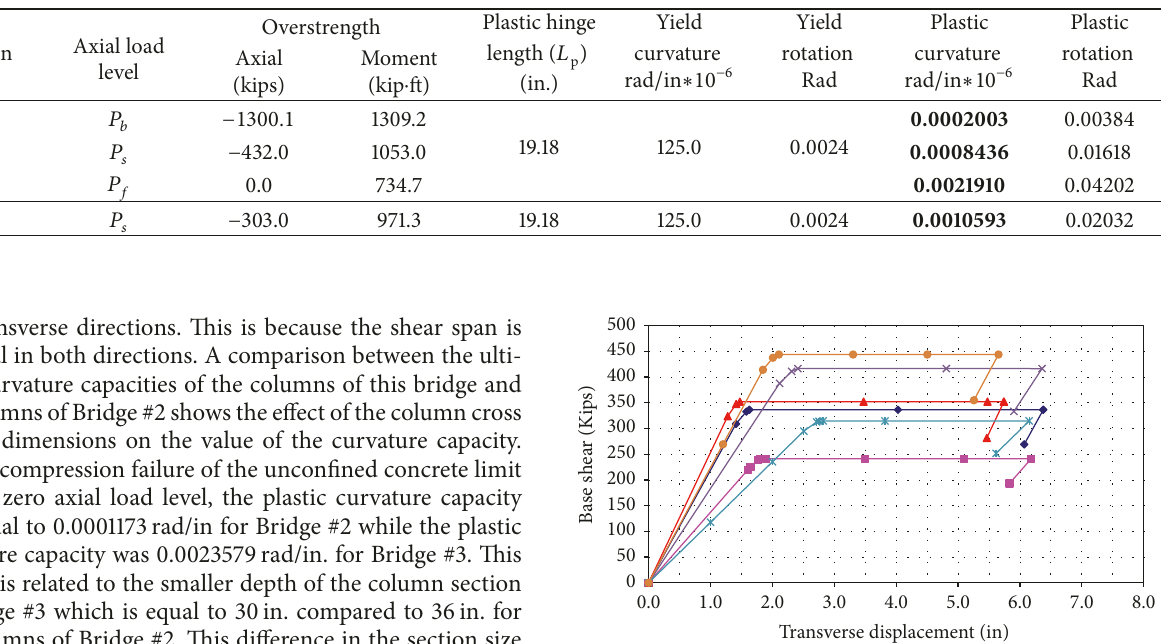
Table 13: User-defined plastic hinge properties of Pier #2 columns, Bridge #3-E.